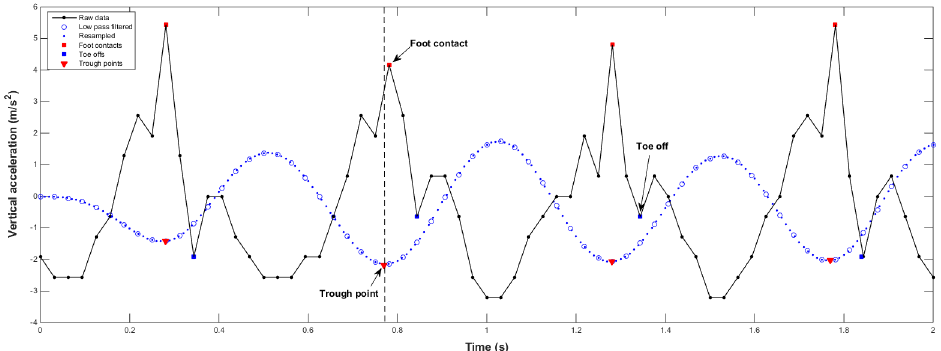
Fig 1. Data processing procedures to detect the instant of foot contact Foot contacts and toe offs are annotated on the raw vertical acceleration data. Trough points are took from processed data (i.e. filtered, interpolated, and resampled data) to estimate the instant of foot